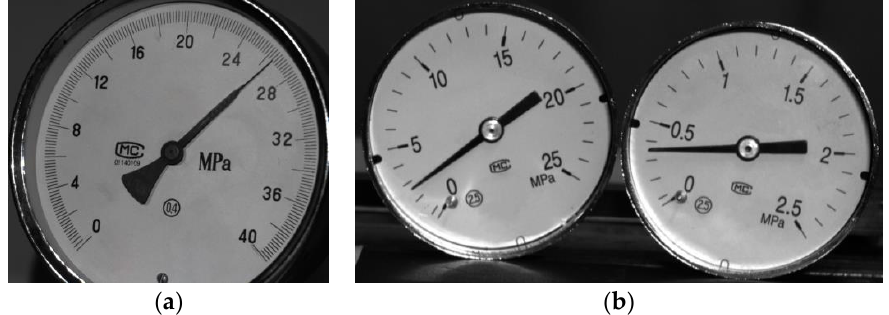
Figure 4. ( a ) measured pointer meter with radius of 620 mm; ( b ) measured pointer meters with a radius of 406 mm.